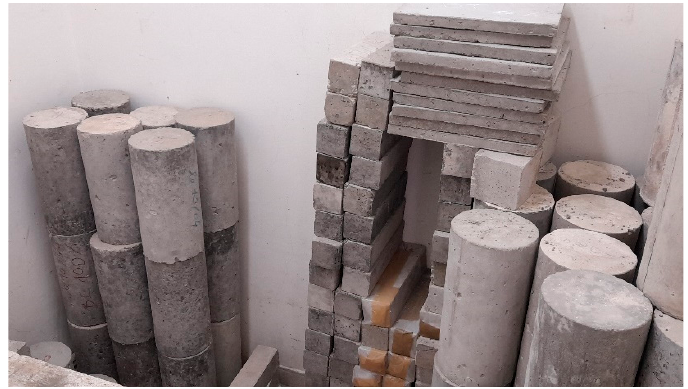
Figure 2. Conservation of the different types of test specimens at room temperature.